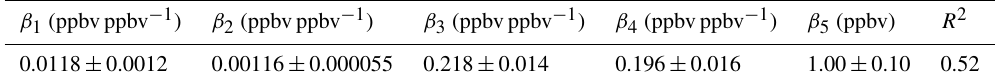
Table 2. Parameters of the multiple linear regression fit and the linear correlation coefficient ( R 2 ) for the measured and source-apportioned HCHO in Eq. (4). β 1 denotes the portion of HCHO from photochemical production. β 2 , β 3 , and β 4 are the emission ratios of HCHO with respect to CO, benzene, and toluene, respectively. β 5 represents HCHO concentration in the background atmosphere. β 1 (ppbvppbv − 1 ) β 2 (ppbvppbv − 1